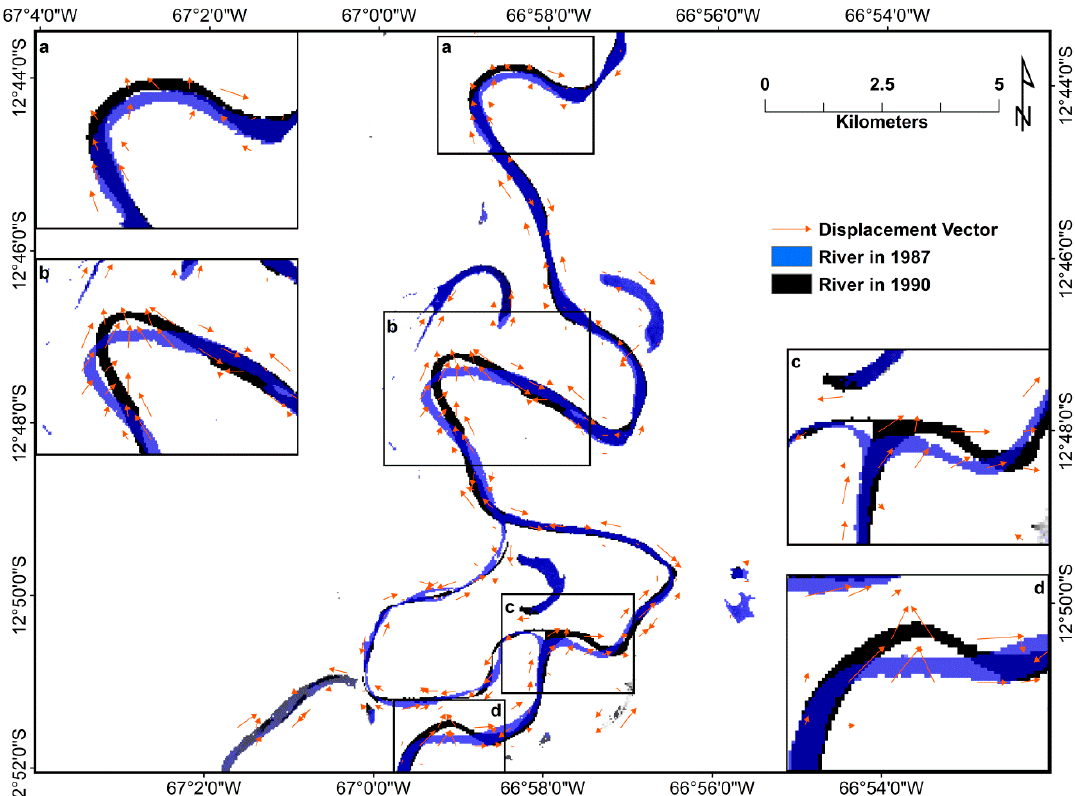
Figure 6. River class-membership images for 1987 and 1990, and MCC vectors (in red) derived from this pair of images. The 1987 river layer and the 1990 river layer (after change) are shown in blue and black, respectively (blue is 30% transparent and overlaid on black layer). Four inset zoom-in windows along the figure margins correspond to their respective specific areas along the river reach, identified by their corresponding labels ( a–d ).